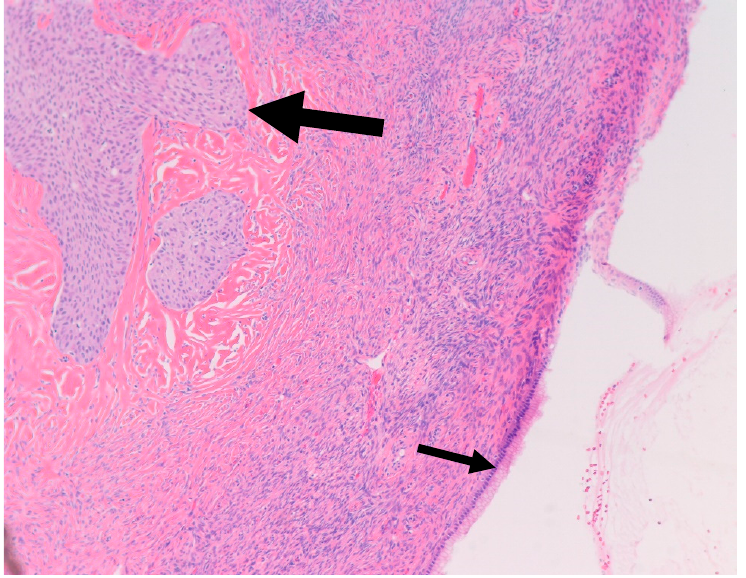
Figure 7. H&E microscopic image of a Brenner tumor (Large arrow) found in the wall of a mucinous cystadenoma (Small arrow). Notice the close proximity between the two components (100× magnification).